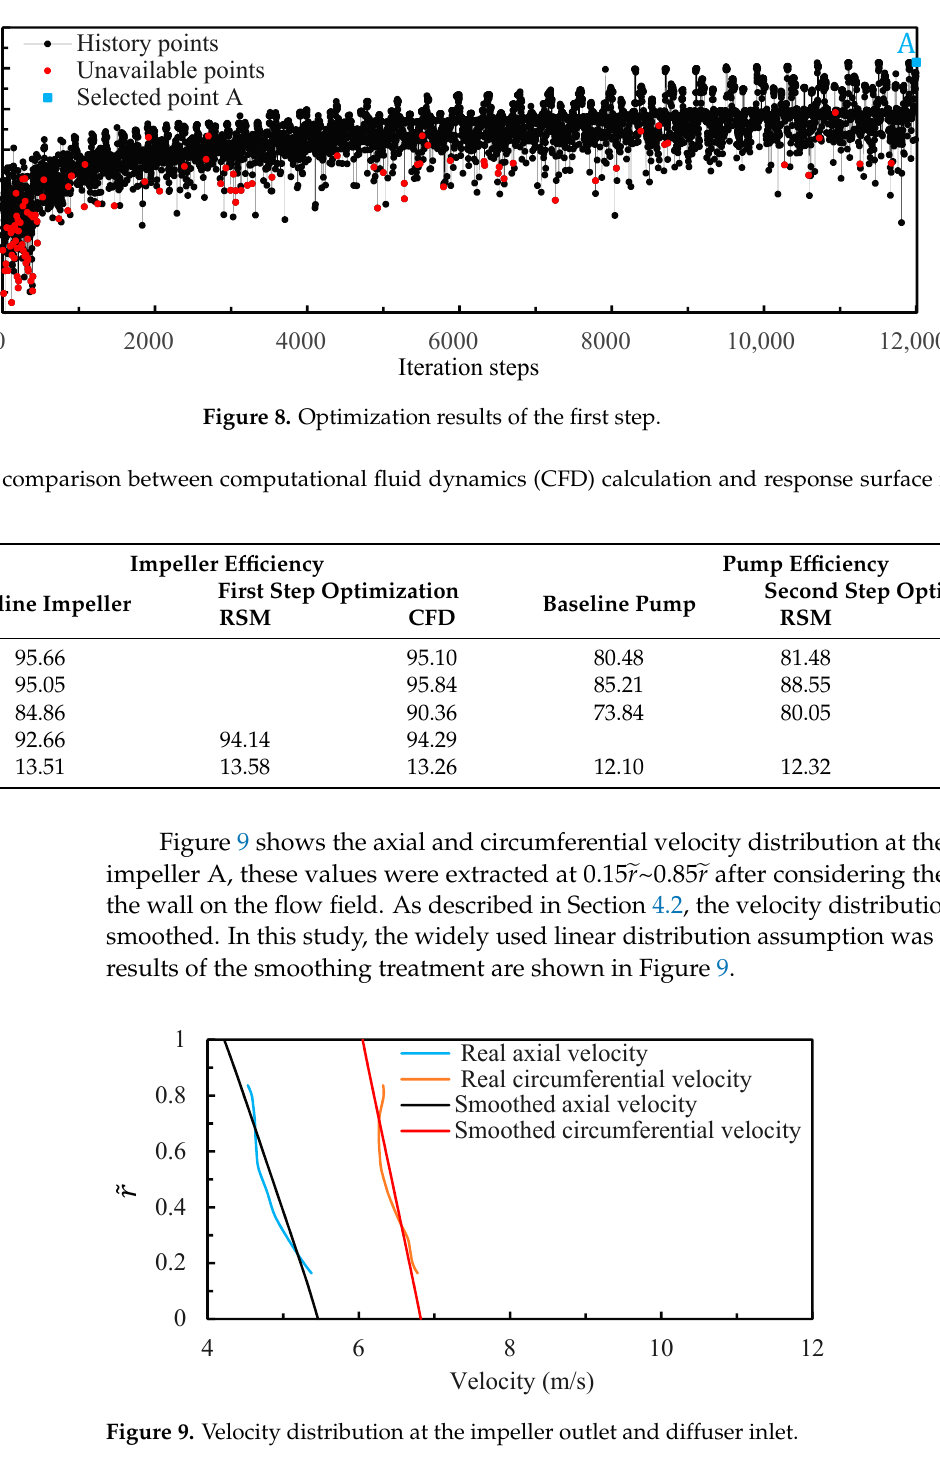
Figure 9. Velocity distribution at the impeller outlet and diffuser inlet. Table 4. Performance comparison between computational fluid dynamics (CFD) calculation and response surface method (RSM) prediction.